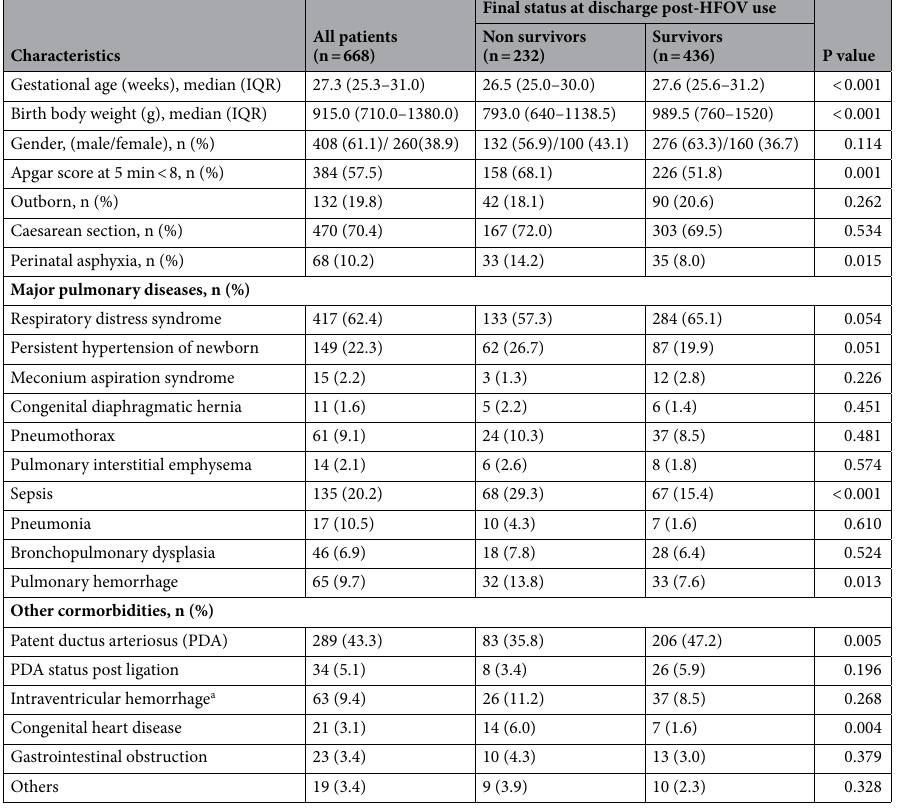
Table 1. Baseline characteristics, clinical and biological features at the time of HFOV initiation according to final survival status. Results are presented as n (%) or median (25th, 75th percentiles). a Intraventricular hemorrhage ≥ grade III.